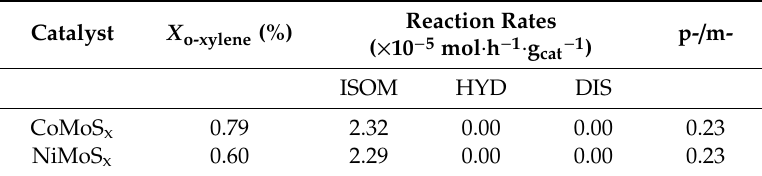
Table 3. Catalytic activity data at 24 h of t.o.s. under N 2